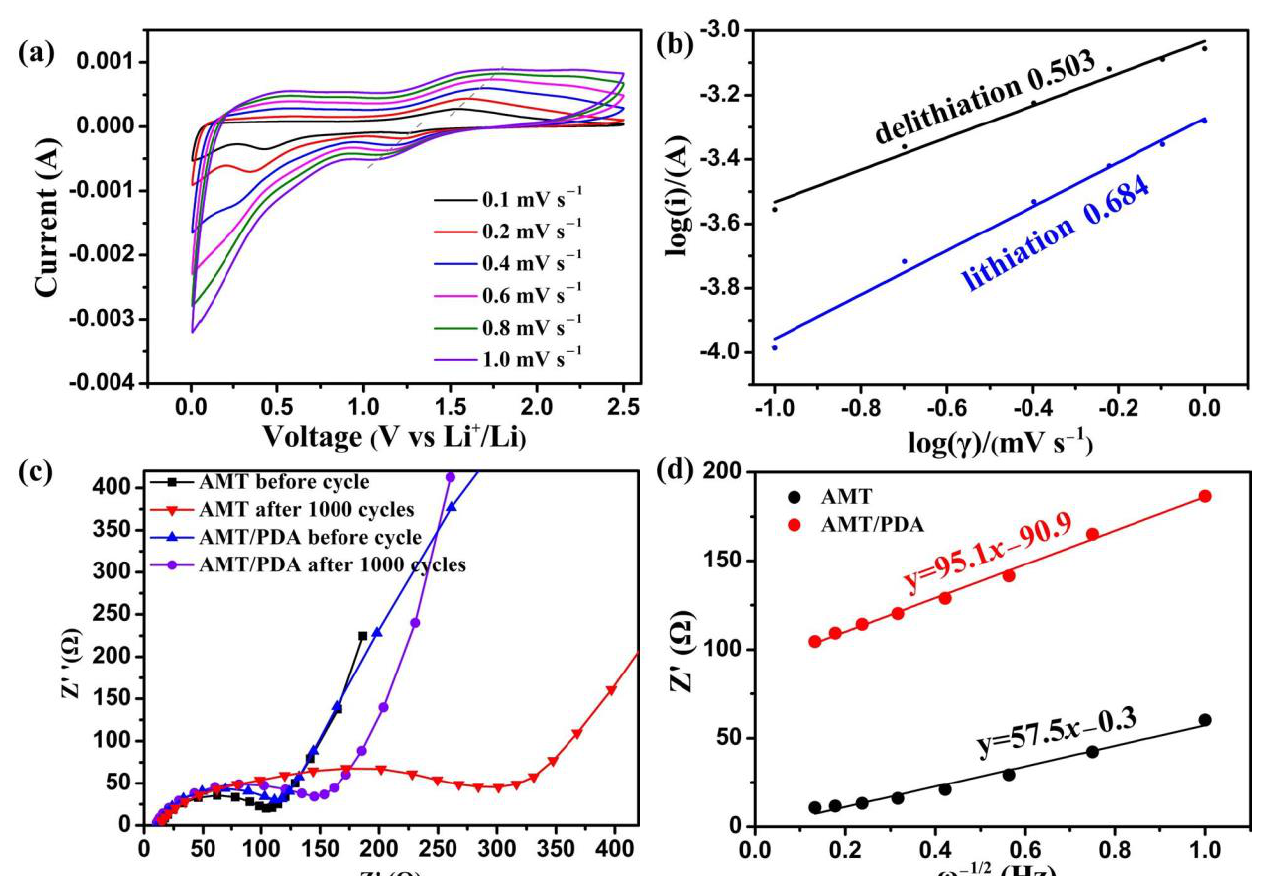
Figure 3. ( a ) Cyclic voltammograms of AMT/PDA electrode at different sweep rate from 0.005 V to2.5 V, ( b ) Plot of log(i) vs. log(v) from the cathodic segment at different scanning rates from Figure 3a, ( c ) EIS spectra of the fresh and cycled AMT and AMT/PDA electrodes, ( d ) Plot of Z’ vs. ω −1/2 , derived from Figure 3c